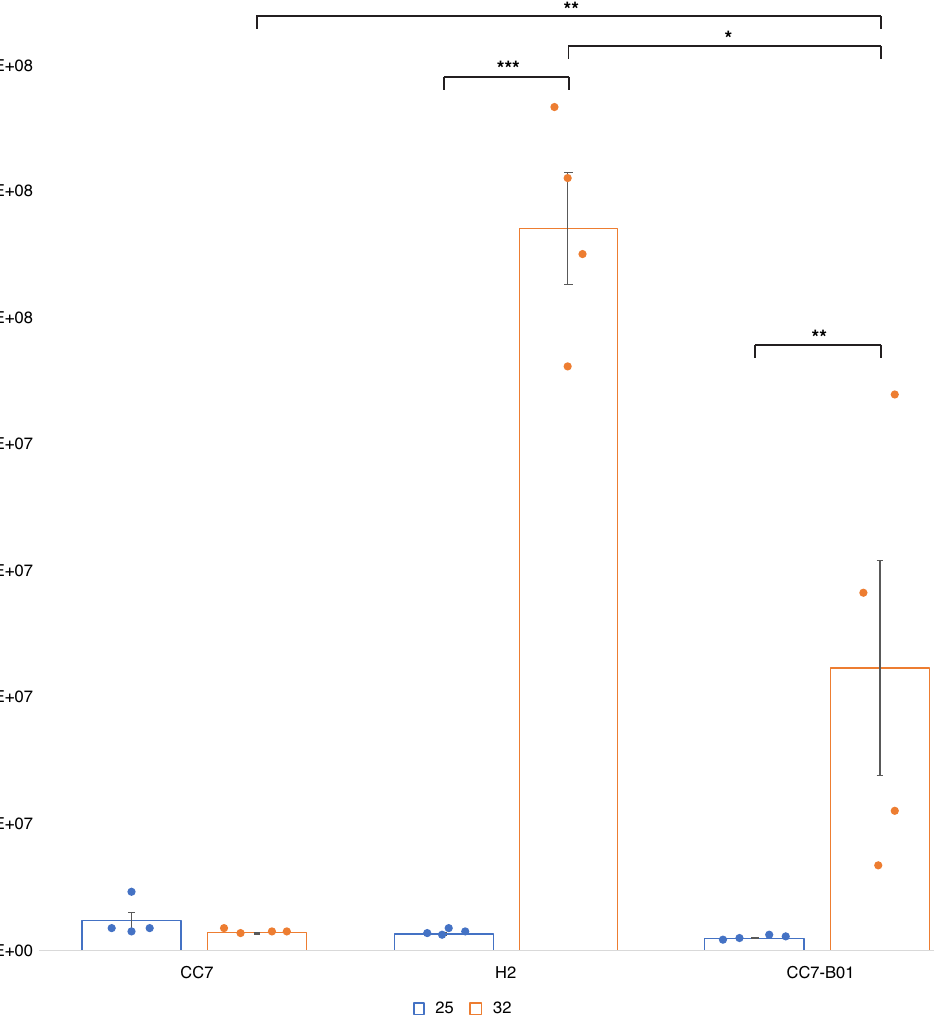
Fig. 3 Caspase-3 activation at control and after heat stress in CC7, H2, and CC7-B01. Blue and orange bars are caspase-3 activation at control and heat stress exposure after 24 h, respectively, with standard error ( n = 4). Signi fi cant differences are denoted with asterisk (* = p < 0.05 ** = p < 0.01, *** = p < 0.001) and absence indicates no signi fi cant differences. Caspase activity was measured in relative fl uorescent units and normalized per unit of protein (mg).